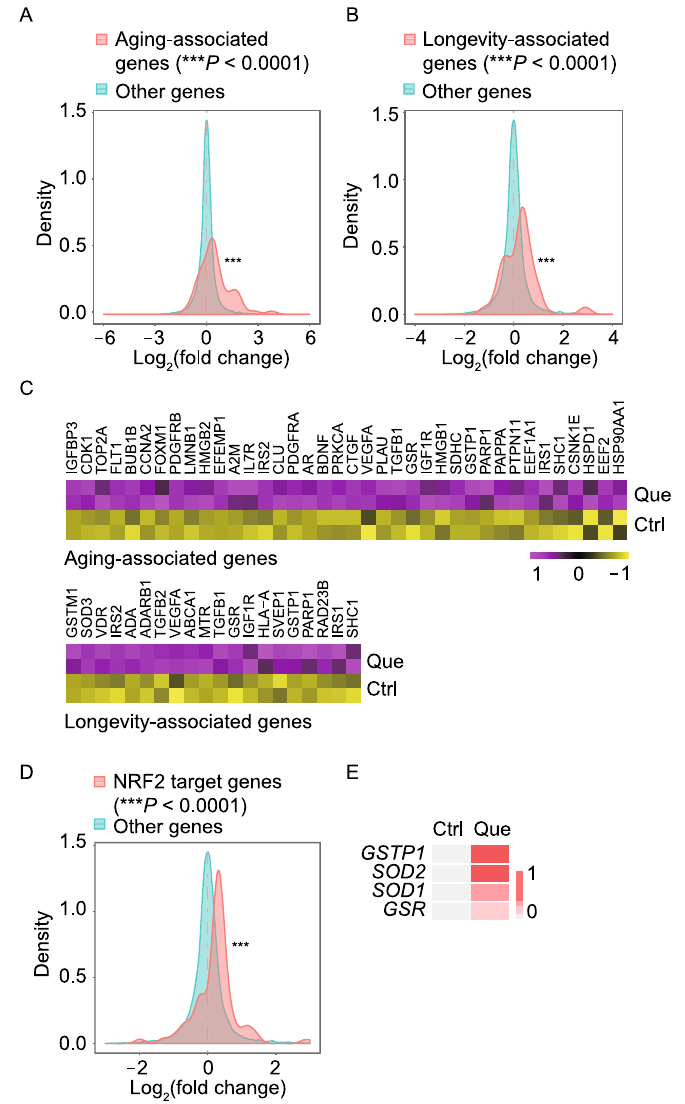
Figure 7. Gene expression analysis revealed the regulation of aging/longevity-related genes, and NRF2 target genes upon Que treatment. (A) Density plot showing Log 2 (fold change) of mRNA expression levels between Que-treated and vehicle-treated (Ctrl) WS hMSCs for aging-associated genes. A rightward shift (*** P < 0.0001) indicates increased frequency of genes upregulated upon Que treatment. (B) Density plot showing Log 2 (fold change) of mRNA expression levels between Que-treated and Ctrl WS hMSCs for longevity-associated genes. (C) Heatmap showing upregulated genes associated with aging and longevity upon Que treatment. (D) Density plot showing Log 2 (fold change) of mRNA expression levels between Que-treated and Ctrl WS hMSCs for NRF2 target genes. (E) RT-qPCR analysis of the transcriptional levels of NRF2 target genes in vehicle- and Que-treated WS hMSCs ( n = 3) (passage